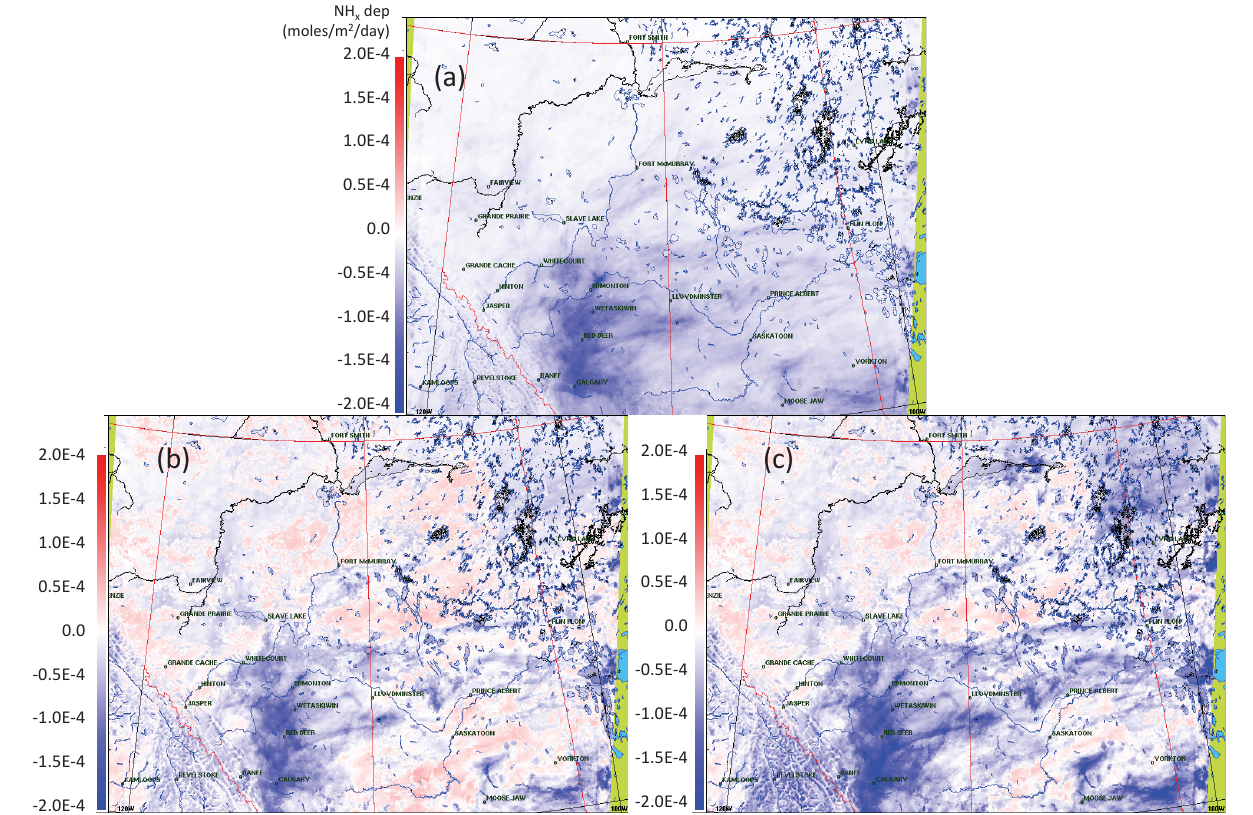
Figure 13. Maps of the modelled average NH x deposition for (a) base, (b) bidi, and (c) fire + bidi models. In all maps, red/positive represents upward flux and blue/negative represents downward flux. These are daily amounts averaged over 12 August to 7 September